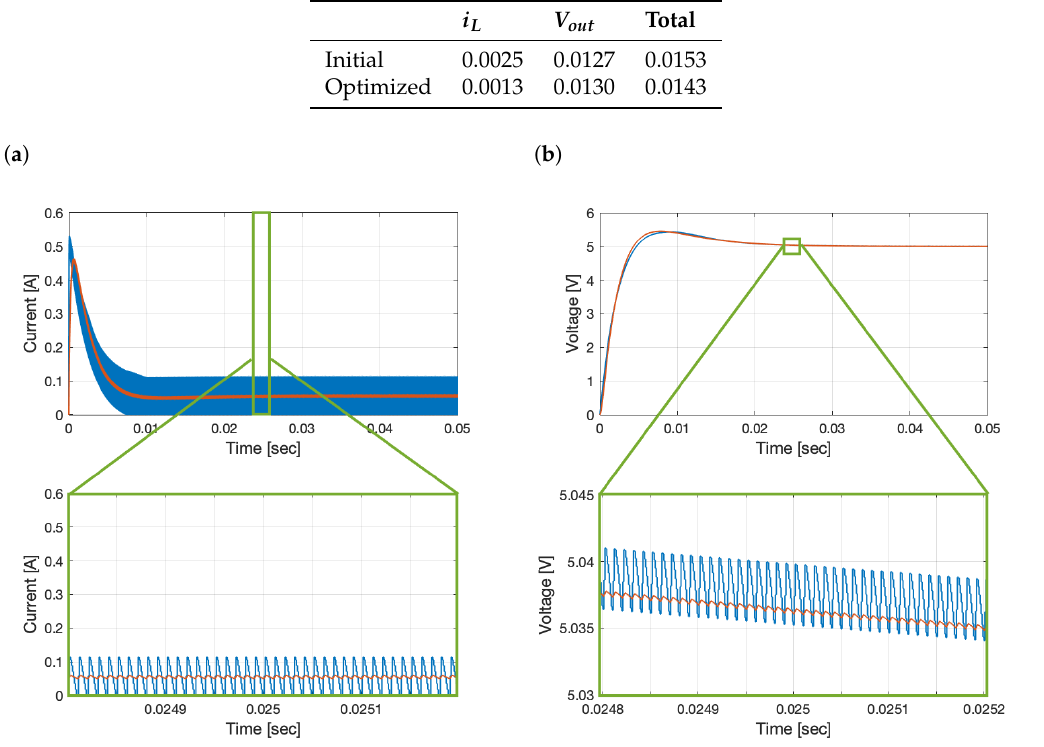
Figure 18. ( a ) Inductor current and ( b ) output voltage response with a 90 [ Ω ]